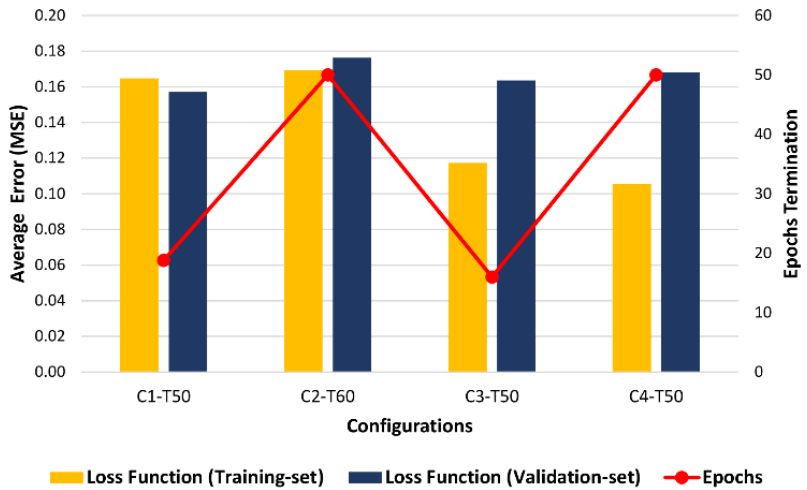
Figure 7. Evaluation of training and validation for the best configurations obtained. In addition, to verify the robustness and applicability of the configurations of the previously trained models, we compared the performance of the daily forecast provided by the model with respect to unseen data from the testing-set. In Figure 8, some samples are shown with the forecast of the energy consumption of the building’s heat pump obtained for one day with these configurations.